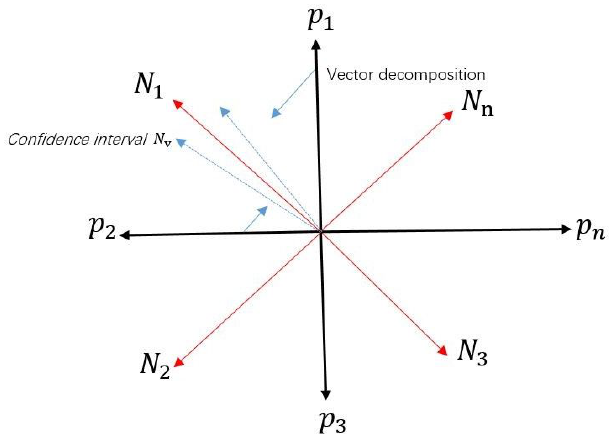
Figure 12: Schematic diagram of high resolution